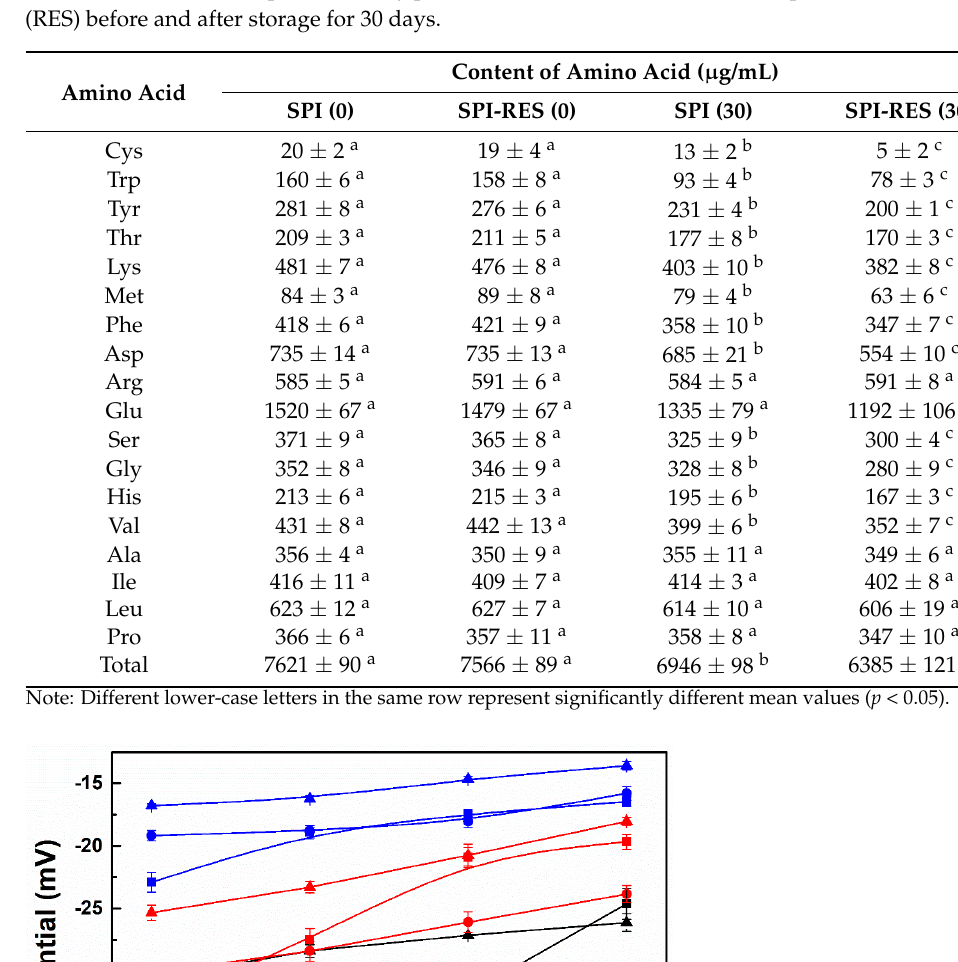
Table 3. Amino acid composition of soy protein isolate (SPI) in the absence and presence of resveratrol (RES) before and after storage for 30 days.